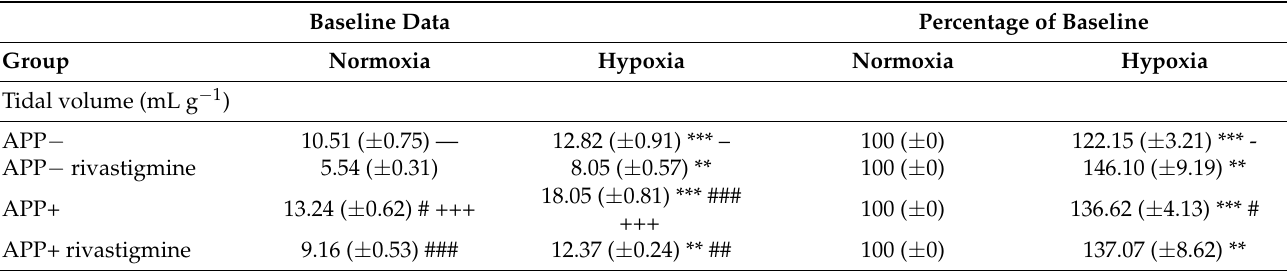
Figure 4. Minute ventilation (V E ) during air breathing (normoxia) and ventilatory response to hypoxia in APP+ (red line) and APP− mice (blue line) before (solid line) and after rivastigmine injection (dashed line) ( A , B ). Minute ventilation expressed as a percentage of baseline (normoxia) values ( C , D ). Note the significant decline of reactivity to hypoxia evoked by rivastigmine only in APP+ mice. The data are presented as mean ± SEM; *** p < 0.001 vs. normoxia value. # p < 0.05, ### p < 0.001 vs. pre-rivastigmine state (n = 6 for APP+ and APP− ). Table 4. Tidal volume (V T ) and frequency of breathing (F) baseline values during air breathing (normoxia) and hypoxia in APP+ and APP− mice before and after rivastigmine injection. In the two right columns, V T and F during the respiratory response to hypoxia are expressed as a percentage of baseline values in normoxia.